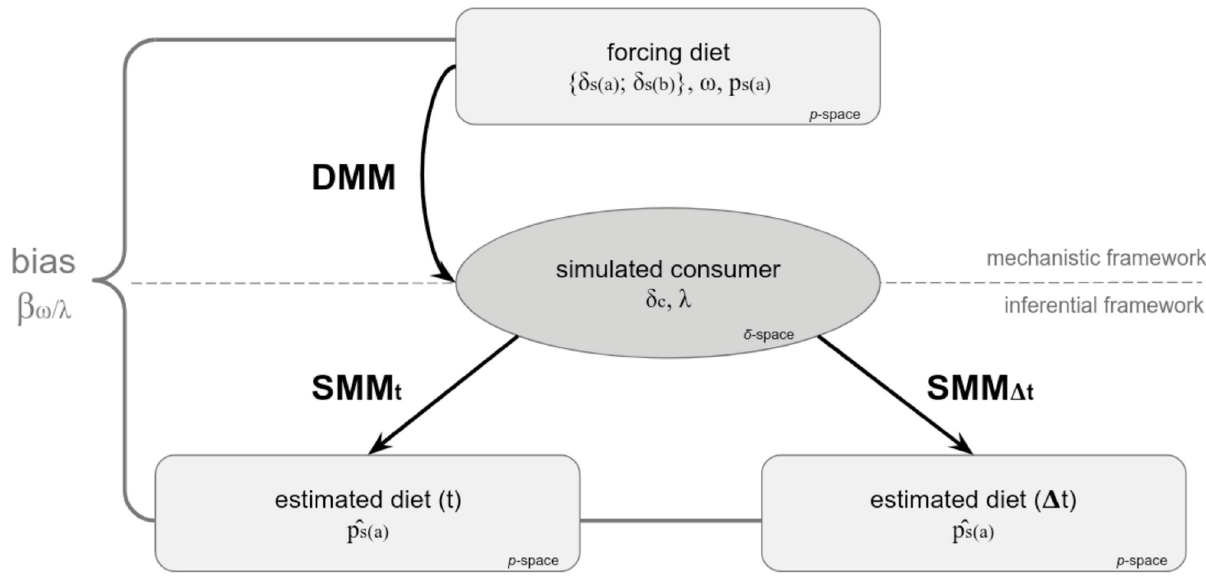
Fig 1. Flowchart representing the procedure for estimating the bias ( b o simulated with the mechanistic DMM under different scenarios of forcing diet ({ δ SMM Δ t provide respectively instantaneous and integrated estimations of ^ p initial forced diet (i.e., p s ( a ) input of the